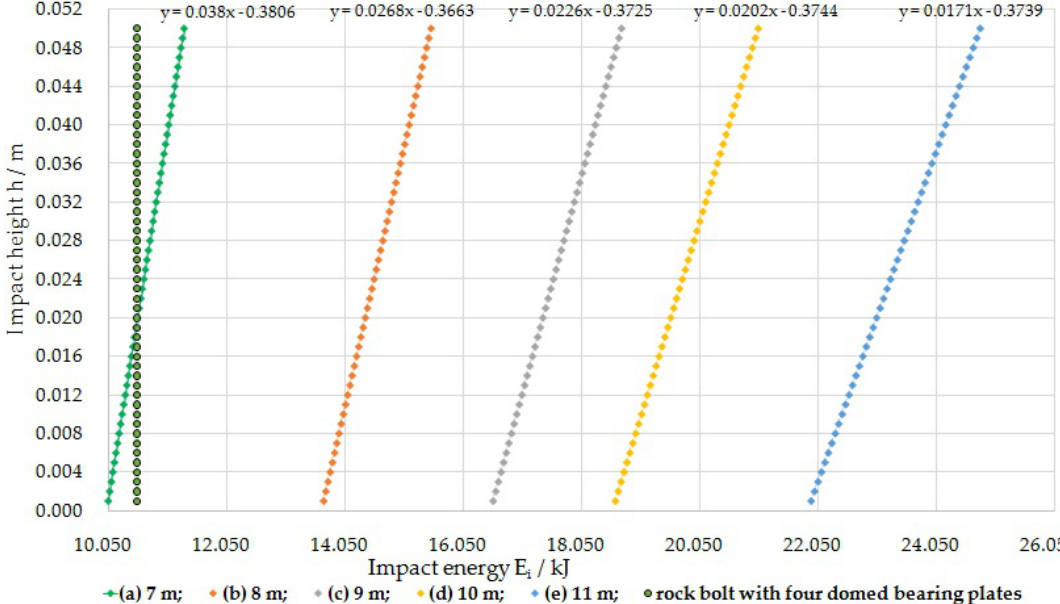
Figure 16. Impact energy for a variable height of drop of roof layer: ( a ) room and pillar with a width of 7 m × 7 m, respectively; ( b ) room and pillar with a width of 8 m × 6 m, respectively; ( c ) room and pillar with a width of 9 m × 5 m, respectively; ( d ) room and pillar with a width of 10 m × 4 m, respectively; ( e ) room and pillar with a width of 11 m × 3 m,